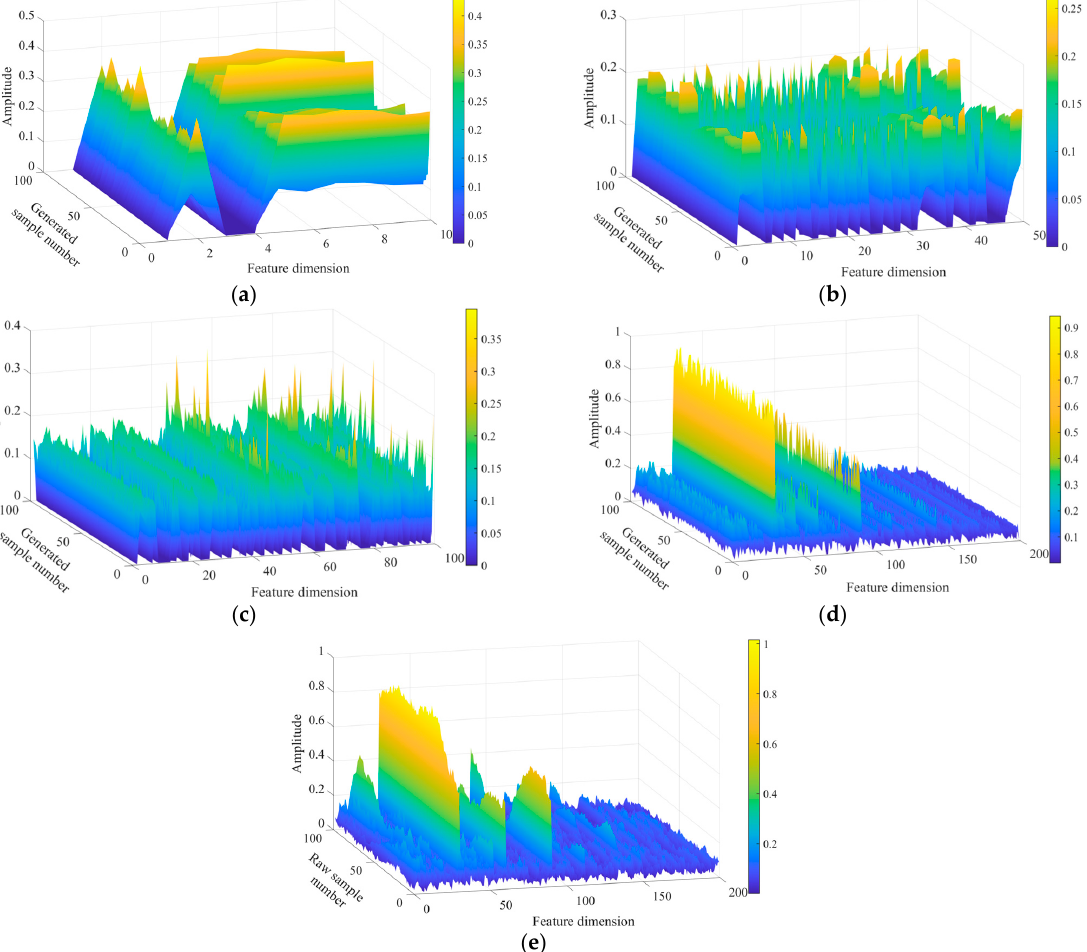
Figure 9. Extracted features of the generator for NC samples: ( a ) the 1st layer, ( b ) the 2nd layer, ( c ) the 3rd layer, ( d ) the output layer, ( e ) the raw sample.